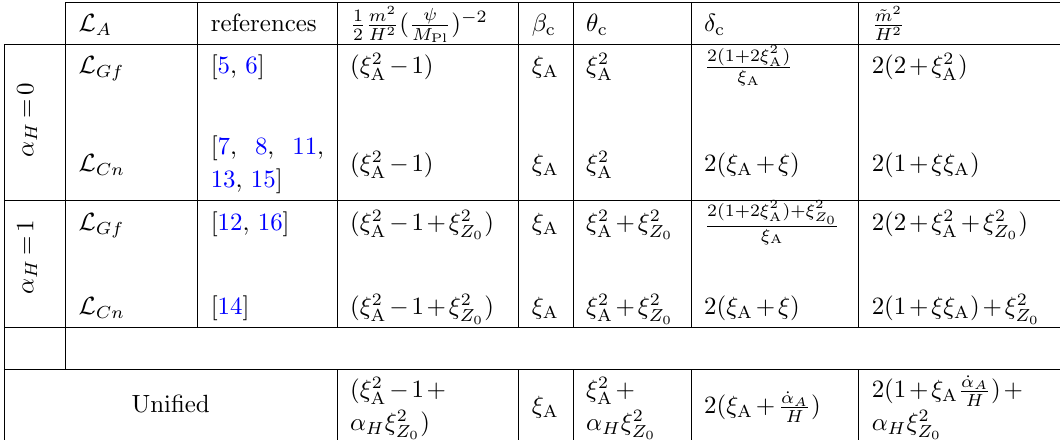
Table 2 . De(cid:12)nition of parameters in the equations of tensor perturbations in (2.24){(2.25) in terms of (cid:24) A , (cid:24) and (cid:24) Z for each type of models. The last row shows the parameters in the uni(cid:12)ed form for 0 the generic action given in